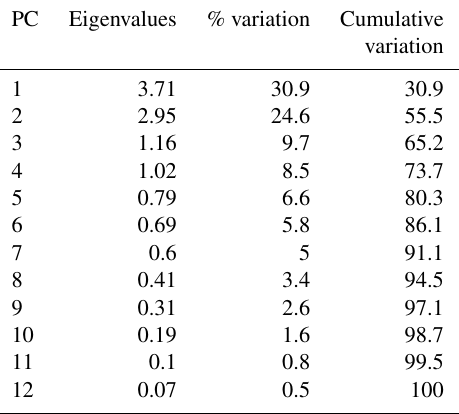
Table 1. Eigenvalues and PCA.